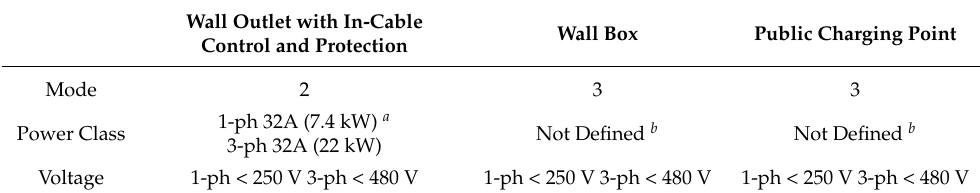
Table 2. Overview of AC charging modes as per IEC 61851-1:2017 (EU, China, India,